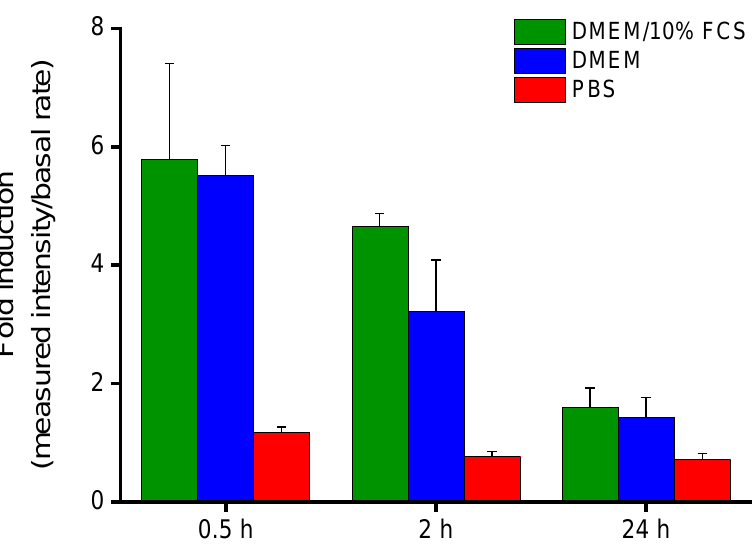
Figure 6. Fold induction values of deposited IFN- β -loaded Alg/NITEGE nanoparticles after coincubation with cell culture medium (DMEM) with and without fetal calf serum (FCS) and phosphate buffered saline (PBS), as reference calculated at three time points.